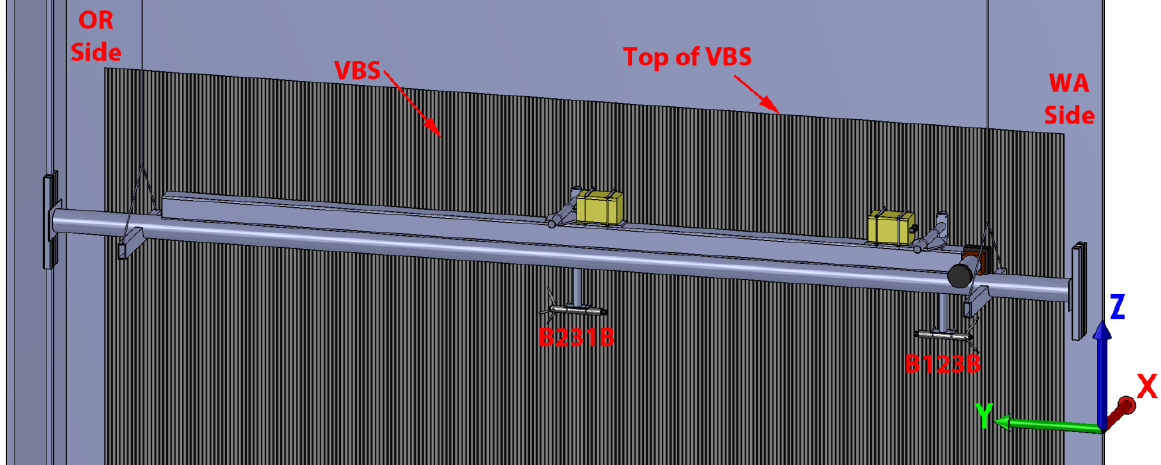
Figure 3. Coordinate system of the 3-D velocity measurement system (Z-origin is at sea level).